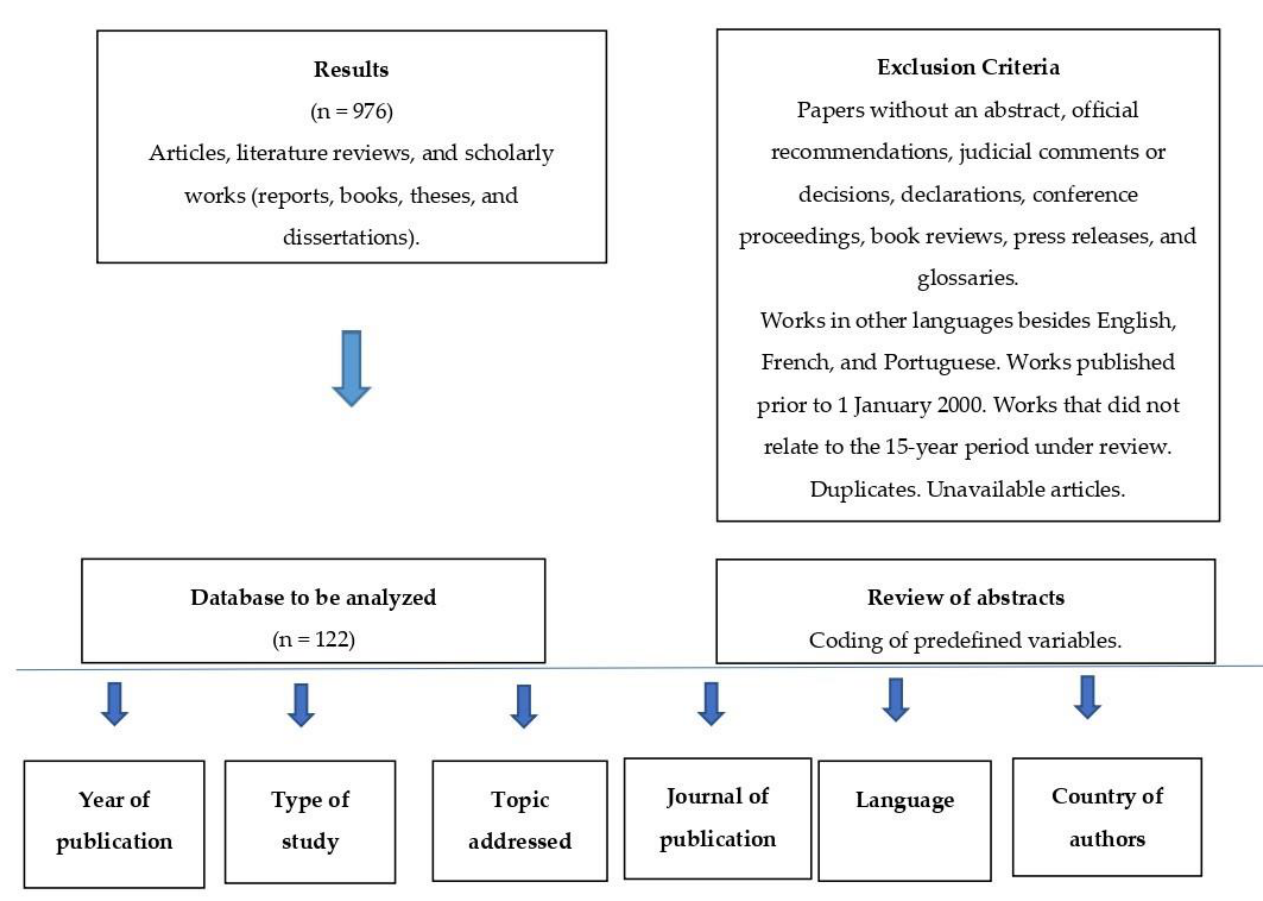
Figure 2. Methodology of the research strategy.